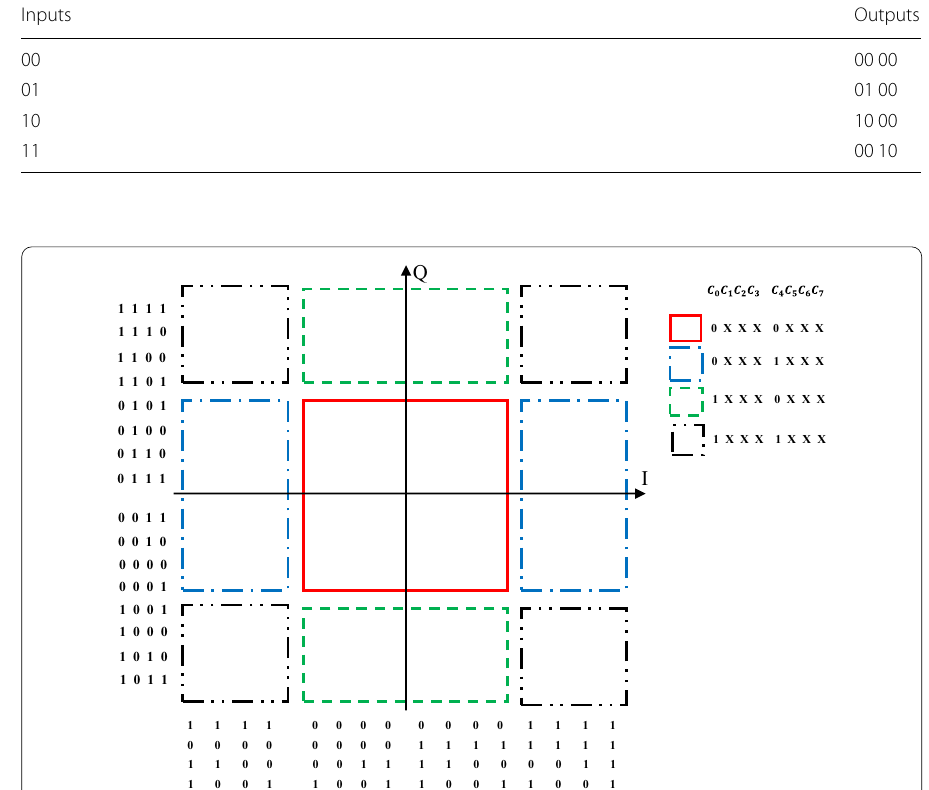
Fig. 3 256 QAM constellation with Gray mapping. The subset partitioning of the 256 QAM constellation used in the present